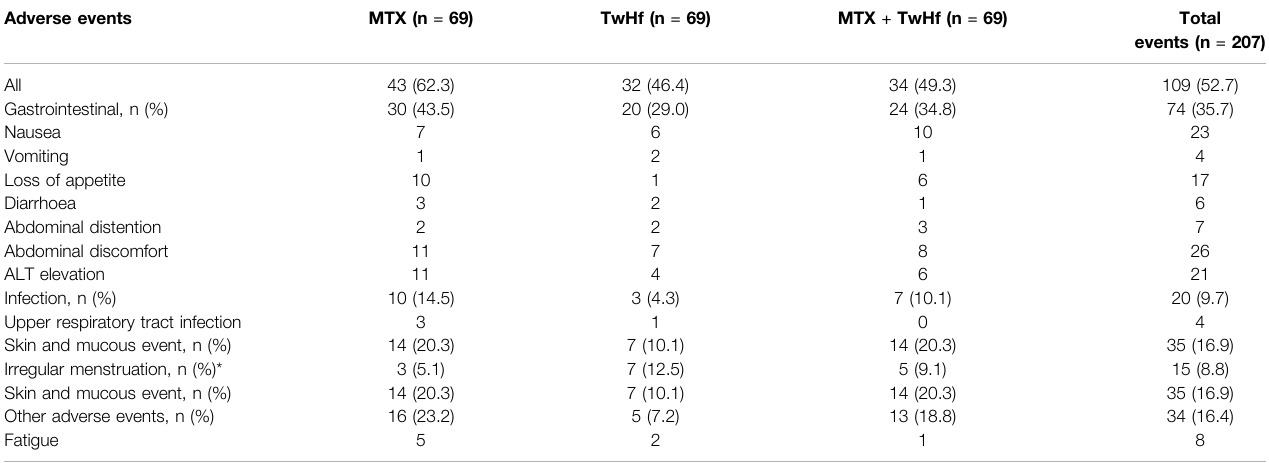
TABLE 3 | Clinical adverse reaction events of Tripterygium wilfordii Hook F Multiglycosides (TwHf) and methotrexate (MTX) in the treatment of motor-active rheumatoid arthritis (Lv et al., 2015), Copyright 2014, Ltd (and EULAR). Adverse events MTX (n = 69) TwHf (n = 69) MTX + TwHf (n = 69)